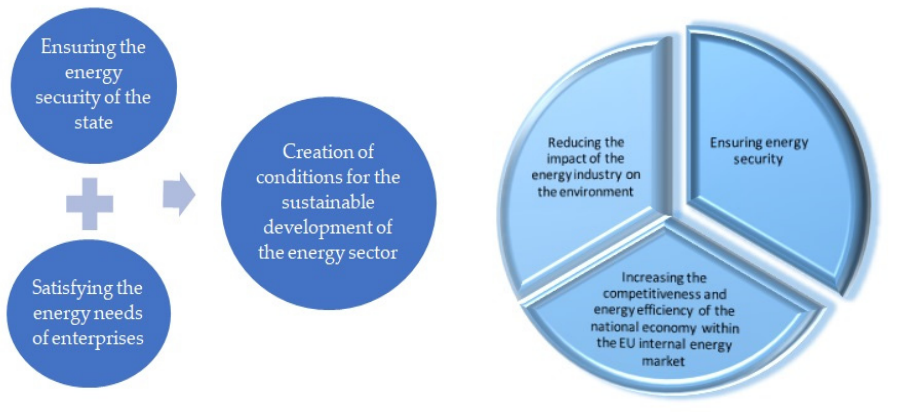
Figure 2. Priority projects until 2050 [27].